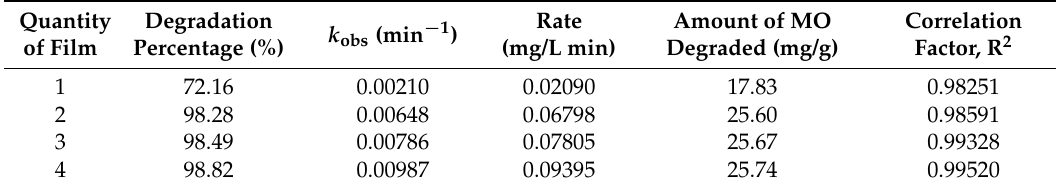
Table 2. Kinetic data and the amount of MO degraded at different initial pH by the PZ ‐ 17 film photocatalyst.